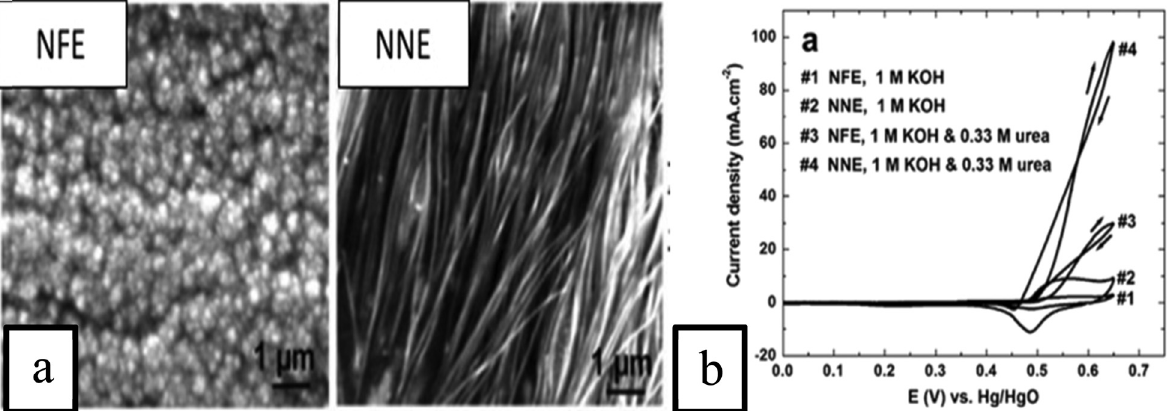
Figure 8: SEM characterization of nickel nanowires in the form of NFE and NNE ( a ) and the CVs of nickel nanowires with di ff erent form in 1 M KOH in the presence and absence of 0.33 M urea ( b ) , republished with permission [ 89 ]